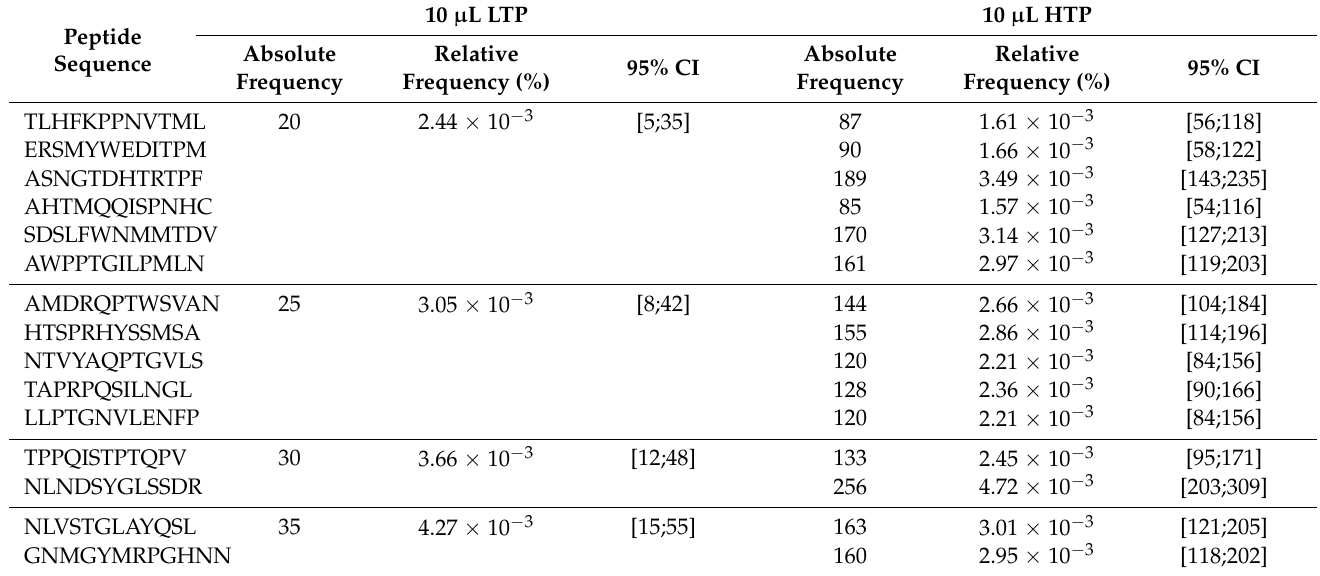
Table 2. Comparison of the capacity to distinguish peptide frequencies between LTP and HTP platforms. Overview of peptide sequences with the same frequency in the 10 µ L LTP dataset but varying frequencies in the 10 µ L HTP dataset. Both the absolute and relative frequencies have been listed for each peptide sequence. Confidence intervals were calculated, and Bonferroni